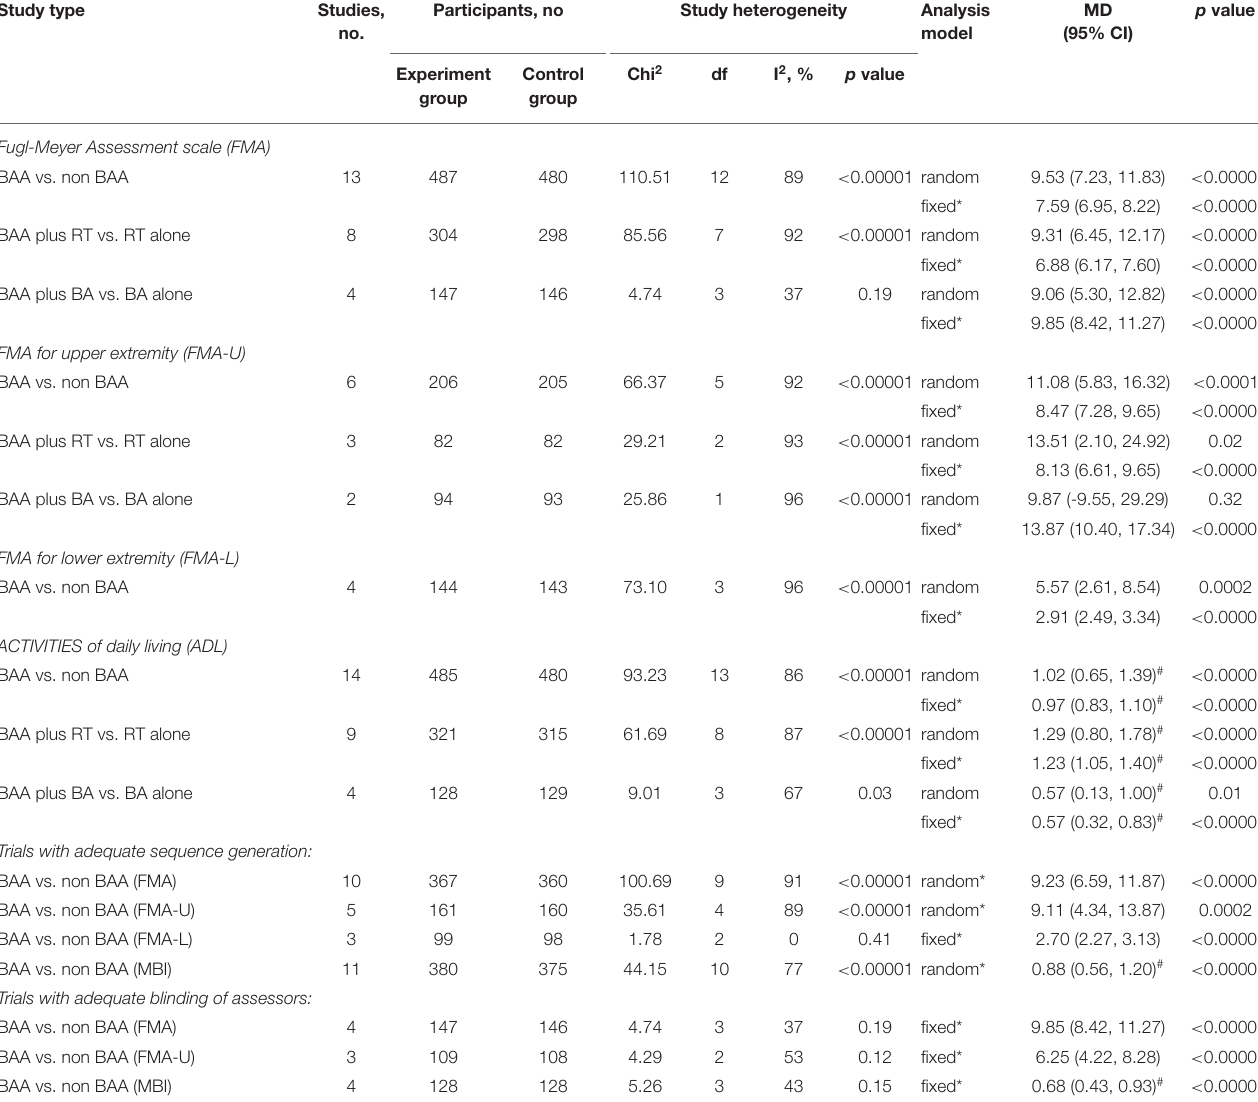
TABLE 2 | Results of sensitivity